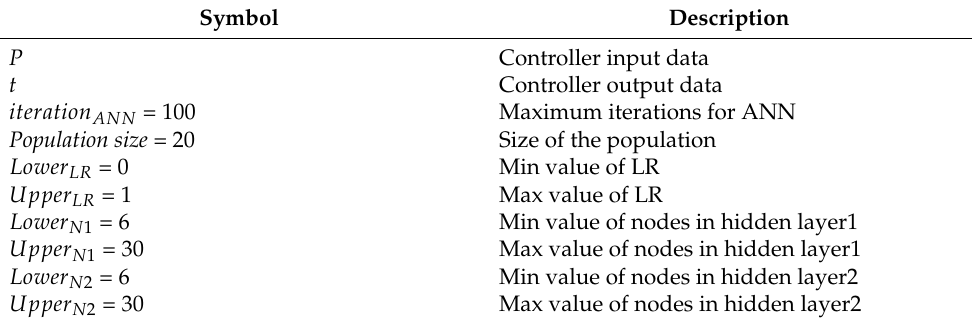
Table 12. Optimization algorithms data and